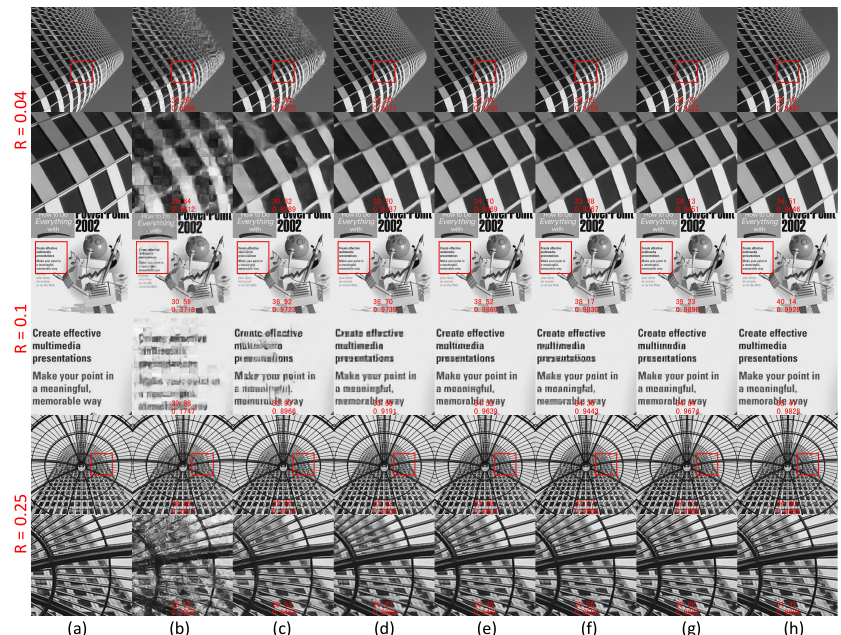
Figure 9. The results for qualitative evaluation. ( a ): Ground truth; ( b ): ReconNet; ( c ): ISTANet++; ( d ): CSNET+; ( e ): AMPNet; ( f ): COAST; ( g ): MADUN; ( h ): Proposed method. The images are randomly selected for comparison under the three sampling ratios of (0.04%, 0.10%, and 0.25%). The detailed parts of the whole image are marked with a red box and shown in an enlarged view below the corresponding image. The indicators of both the complete and enlarged images are calculated and